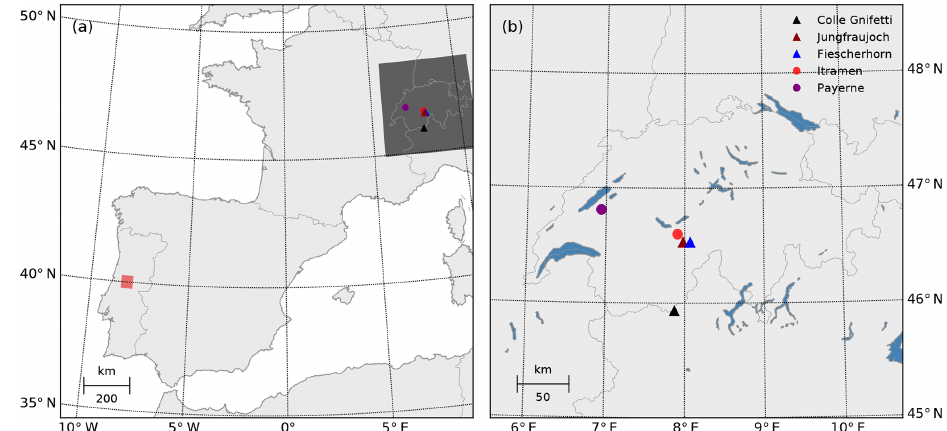
Figure 1. Source and deposition sites. (a) Map of south-western Europe with the area of Pedrógão Grande, in central Portugal, where the fires burned (red box), and the area of the zoom in the right panel (grey box). (b) Map of Switzerland with the sites of interest mentioned in the study. Triangles indicate high-altitude ice-core and snow study sites; circles stand for weather